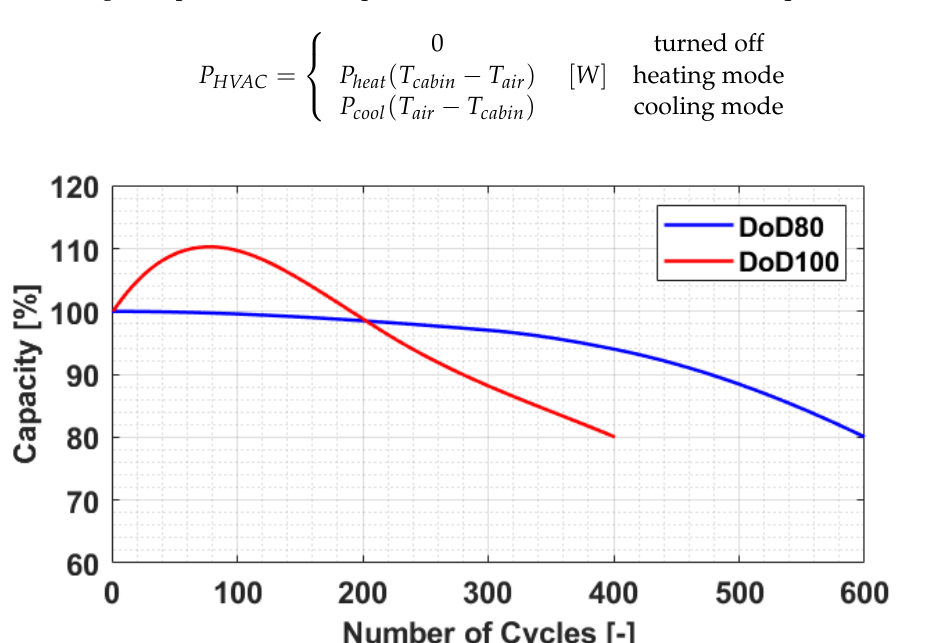
Figure 9. Capacity fading in terms of battery depth of discharge equal to 80% (DoD80) and 100% (DoD100).